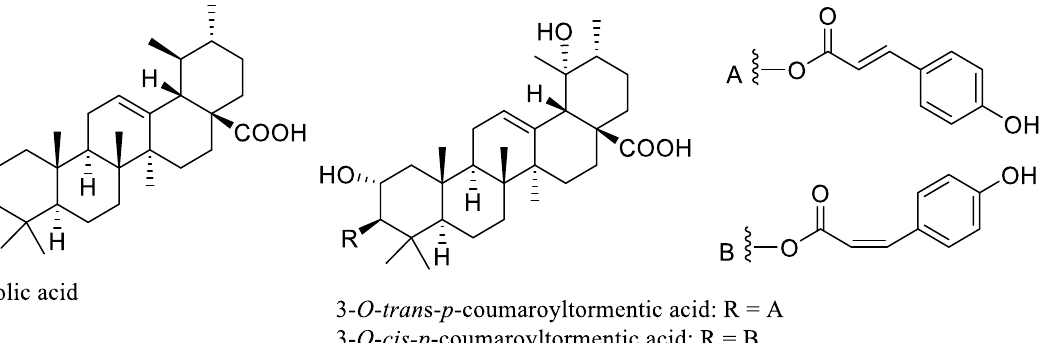
Figure 2. Structures of the triterpene ursolic acid and its derivatives, 3- O - trans - and 3- O - cis - p -cou- maroyltormentic acids isolated from Aronia berries. coumaroyltormentic acids isolated from Aronia